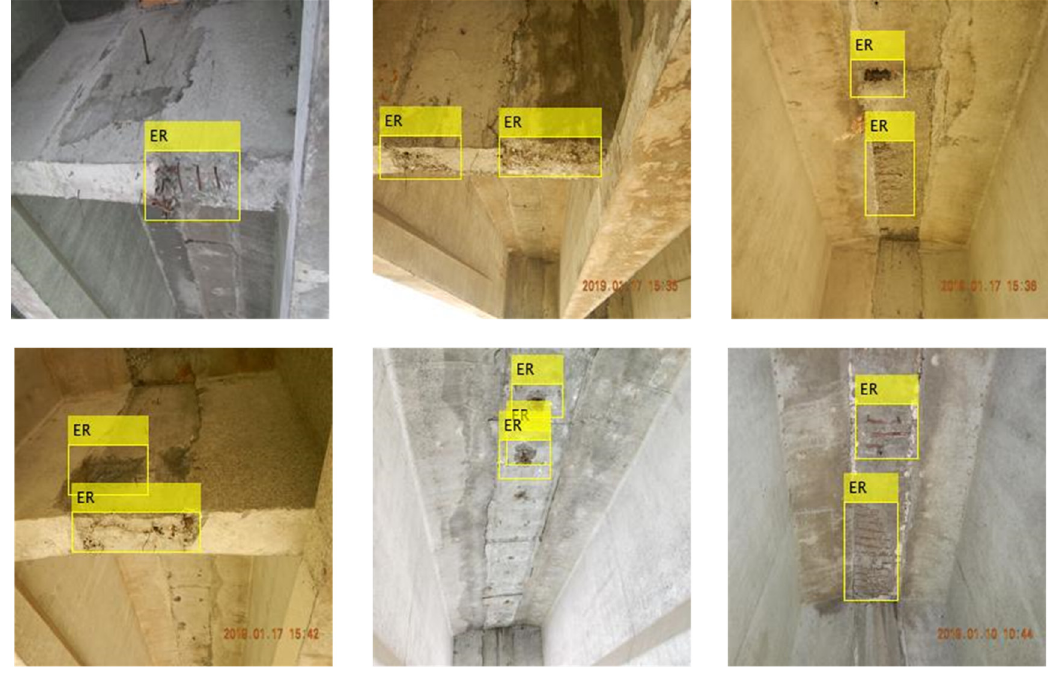
Figure 11. Partial detection results of CR and ER.